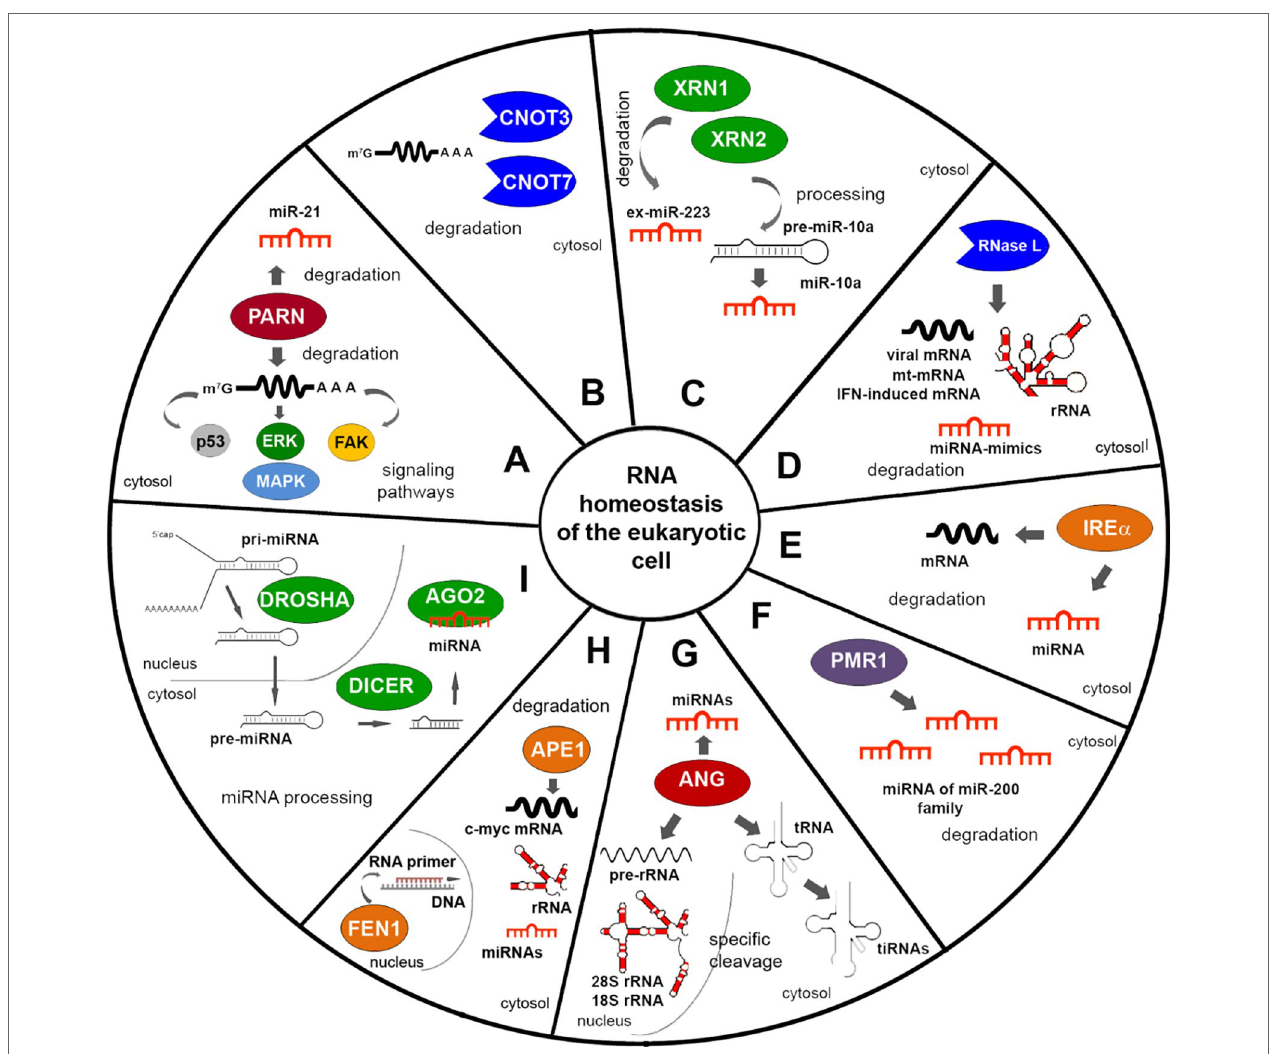
FIGURE 1 | Endogenous RNases providing the maintenance of RNA homeostasis in the eukaryotic cell. (A – C) RNases of conventional RNA decay. (D – F) Stress signal induced RNases . (G) Angiogenin. ( H) Proteins with ribonuclease activity participating in maintenance of DNA integrity. (I) RNases of miRNA biogenesis. The figure shows the targets of RNases and their activity at the level of RNA. Targets for GRBPs are presented in detail in rev. Alam and Kennedy